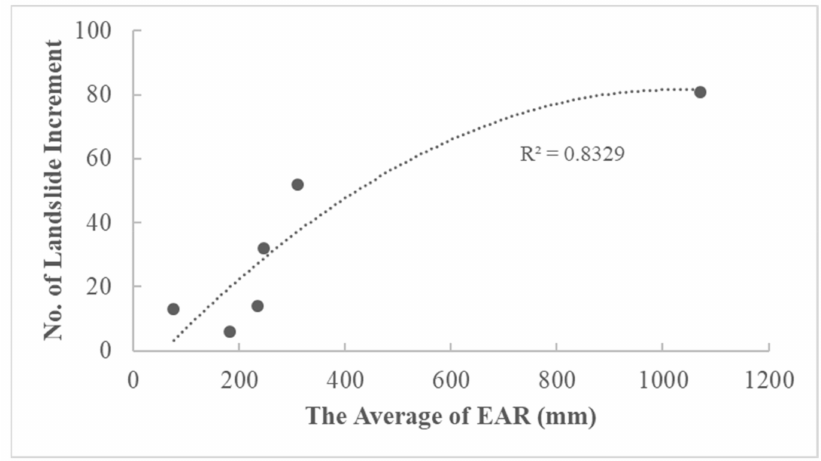
Figure 4. Regression line of the increase in the number of landslides against the average effective accumulative rainfall (EAR).